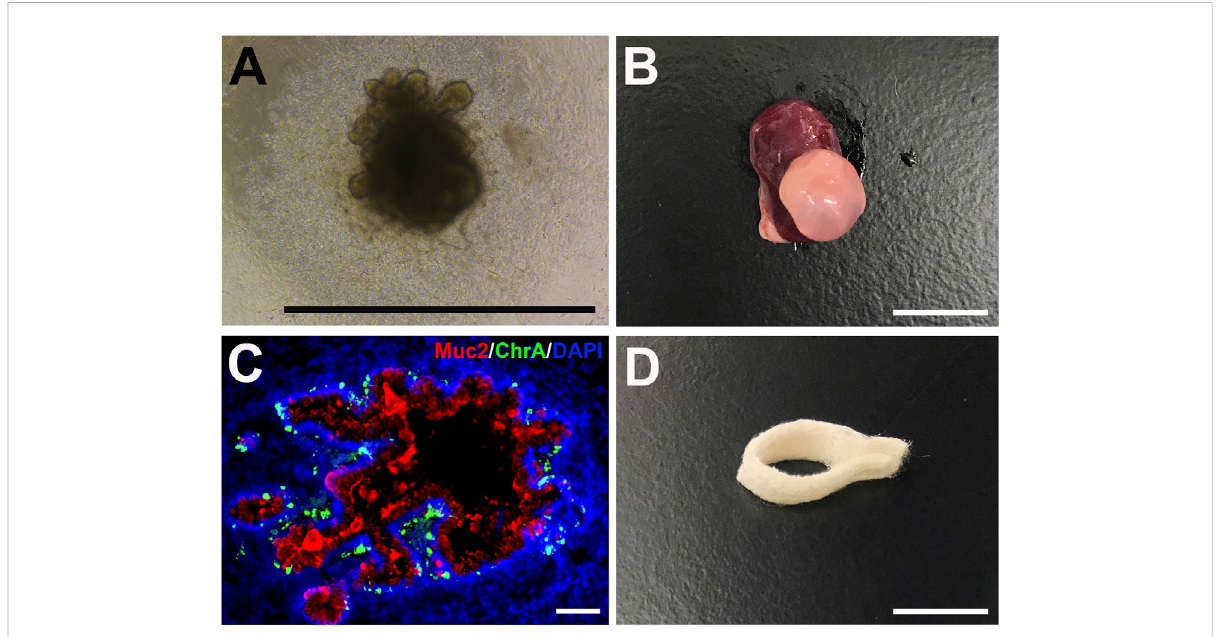
FIGURE 6 Human intestinal organoids (HIOs) and biodegradable scaffolds. (A) Bright fi eld photomicrograph of a PSC-derived HIO after 25 days in vitro (scalebar1 mm) (B) GrossphotoofatransplantedHIO(tHIO)after8 weeks invivo (scalebar1 cm) (C) Immuno fl uorescentstainingofan8 week-old tHIO for goblet cells (Muc2/Cy5) and enteroendocrine cells (ChrA/FITC) (scale bar 100um) (D) Polyglycolic acid and poly-L-lactic acid (PGA/PLLA) biodegradable scaffold can be seeded with cells for the generation of tissue-engineered GI organs (scale bar 1